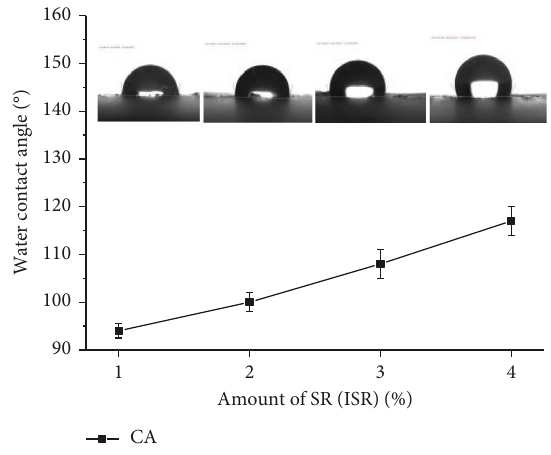
Figure 9: Static contact angles of